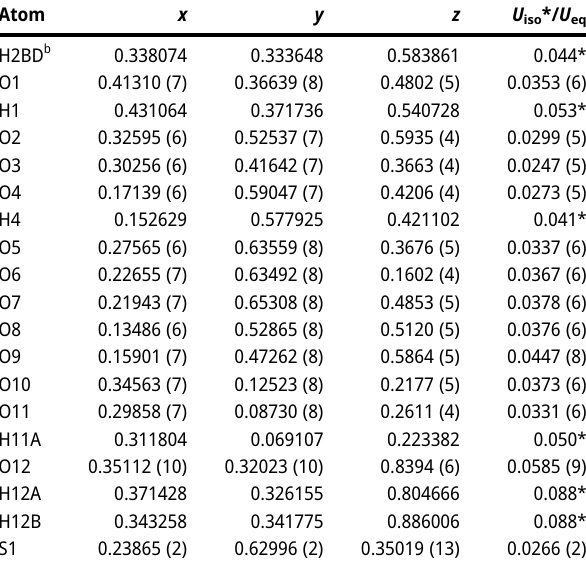
Table  : Fractional atomic coordinates and isotropic or equivalent isotropic displacement parameters (Å 